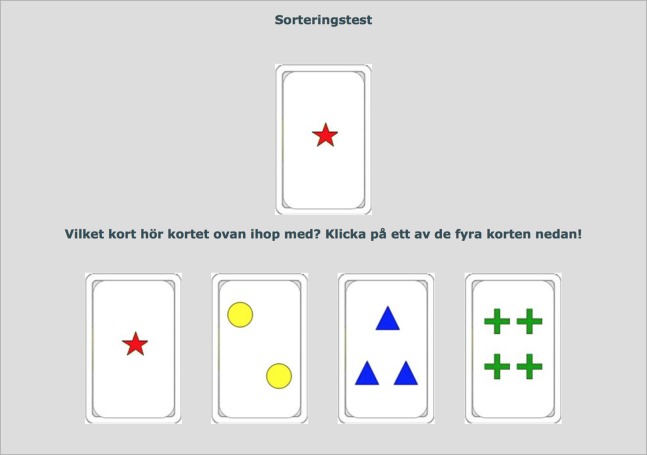
Screenshot of the online WCST.Translation from Swedish: “Sorting test. Which card does the card above belong with? Click on one of the four cards below!”